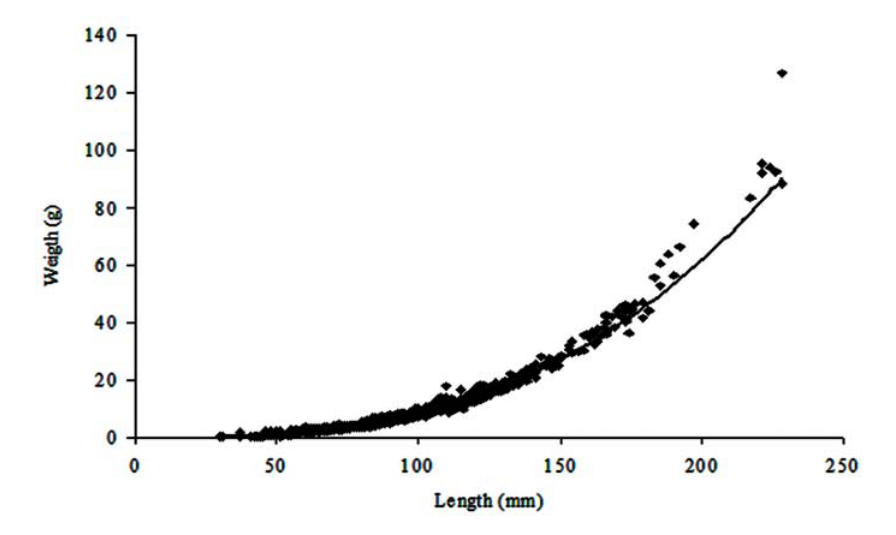
Fig. 7. Length/weight relationships of the species Isopisthus parvipinnis (n = 990) in Ilhéus,